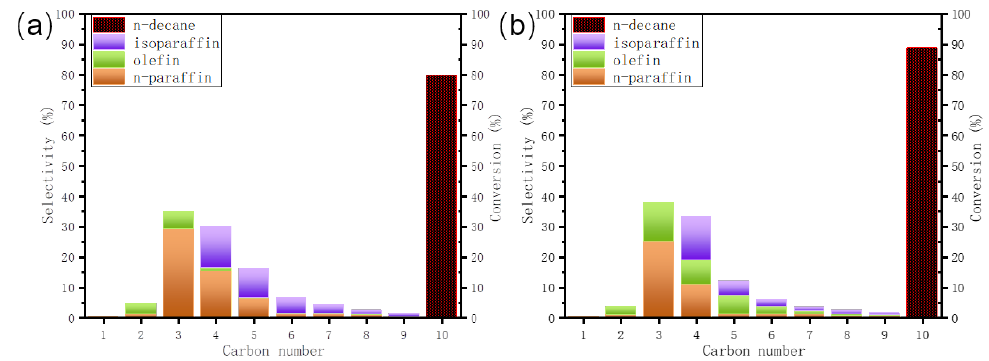
Figure 10. The conversion of the catalytic cracking of n-decane and the products distribution over ( a ) Z–100 and ( b ) Z–100–M. The reaction conditions: Catalyst weight = 0.3 g, F C10 = 0.03 g / min,